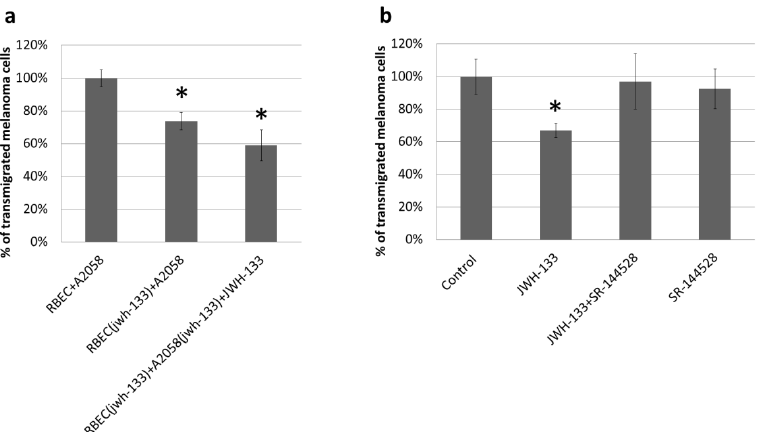
Figure 3. Effect of CB2 activation on the transendothelial migration of melanoma